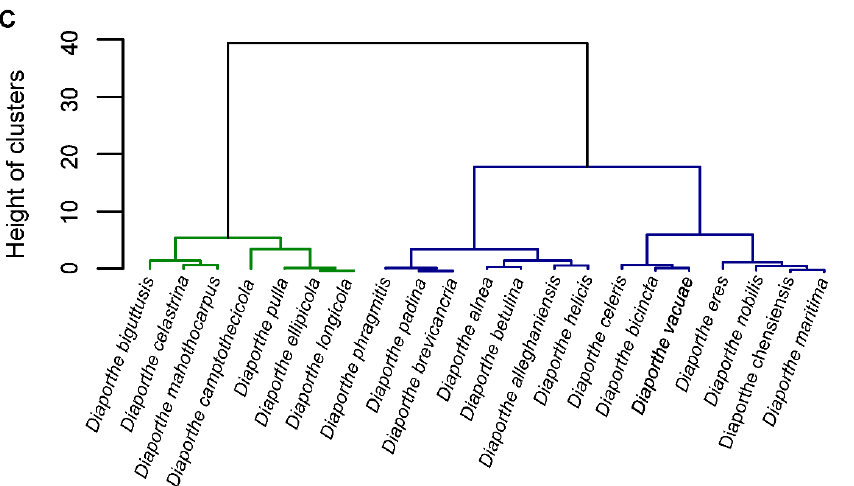
Figure 5. Dendrogram from the hierarchical clustering analysis based on the Ward’s method showing the distribution of the length and width ratio (L/W) of alpha conidia ( A ), beta conidia ( B ) and conidiophores ( C ) of all species isolates from the Diaporthe eres complex. Green, blue and red colors represent the different clusters based on the micromorphological descriptions.